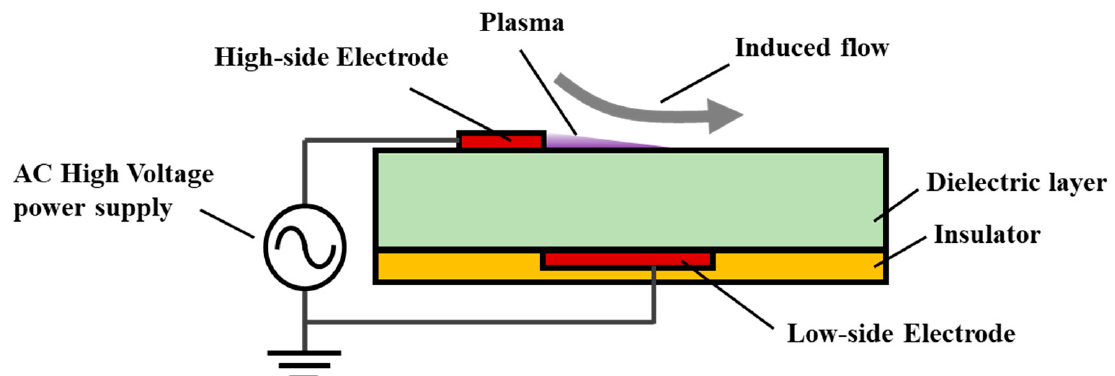
Figure 1. Schematic of a DBDPA.